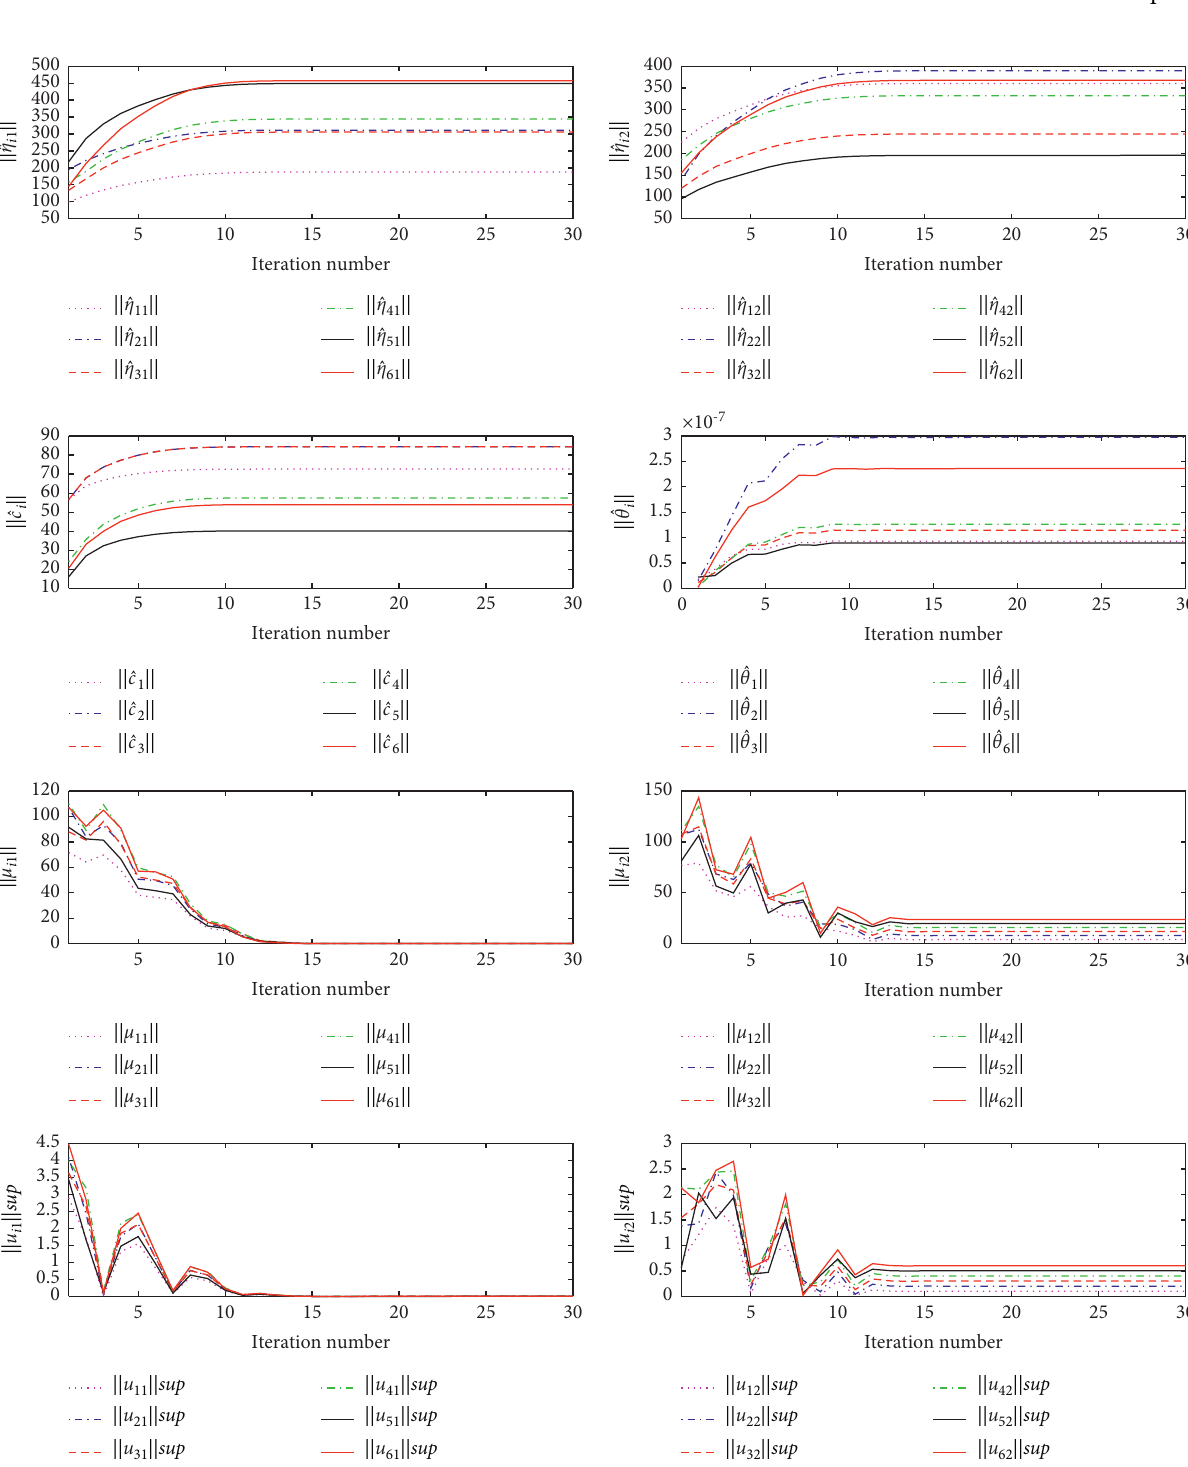
Figure 7: Responses of six followers for Case